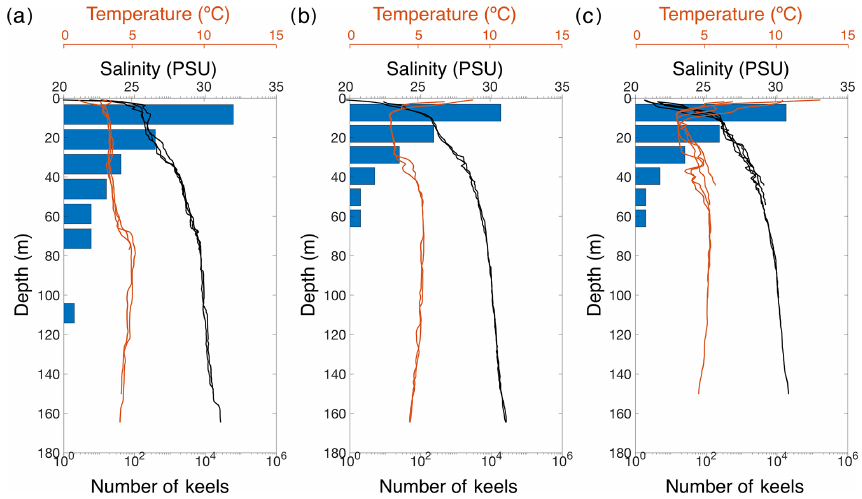
Figure 9. Iceberg keel depths compared to salinity and temperature profiles in Columbia Fjord. Salinity and temperature profiles were collected by the US Geological Survey on 30 and 31 July 2013. Keel depths presented here are from the July 12a icebergs. (a) Proximal zone, (b) mid-fjord zone, and (c) distal zone. Note the log axis for number of keel